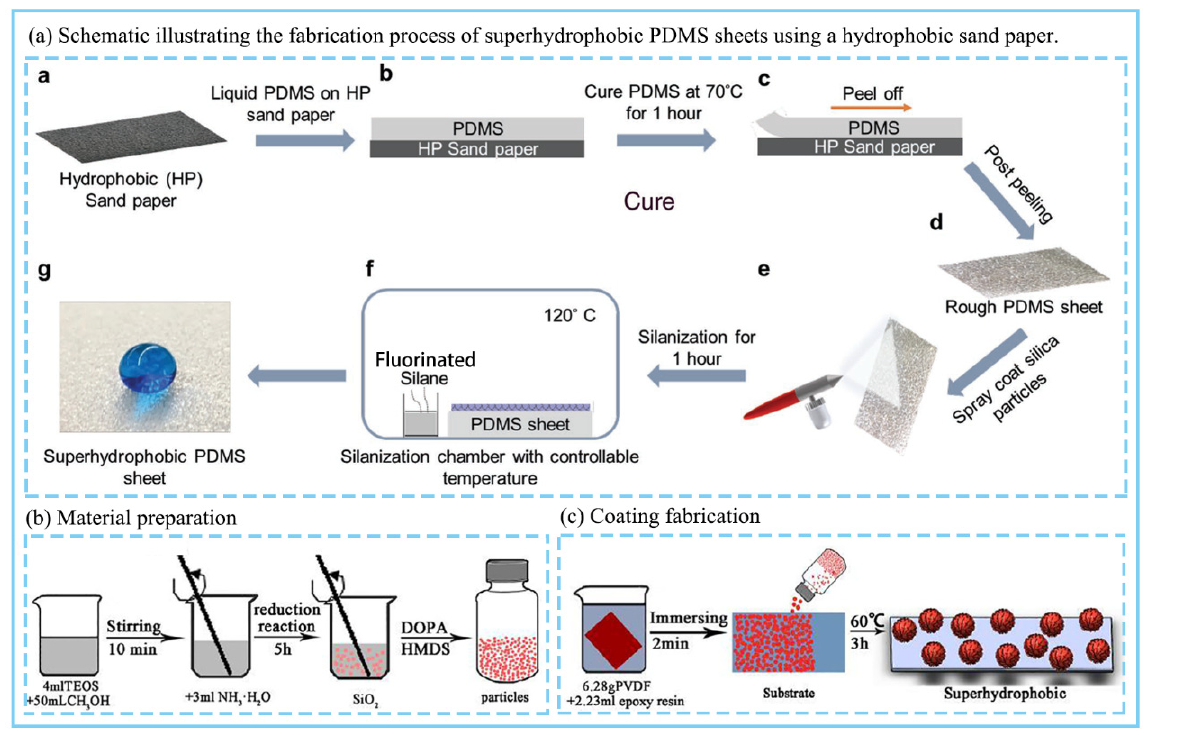
Figure 5. Flow chart for the preparation of superhydrophobic surfaces and the preparation of anti-icing surface coatings. ( a ) Flowchart of superhydrophobic PDMS sheets using hydrophobic sandpaper. ( b ) Preparation of superhydrophobic HMDS-dopa silica powder. ( c ) Flow chart of coating preparation.